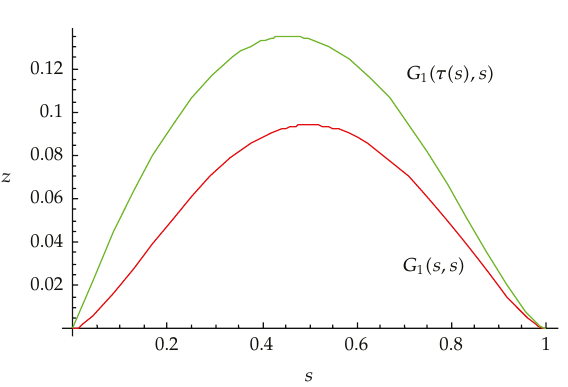
Figure 1: Graph of functions G 1 (cid:6) τ (cid:6) s (cid:7) ,s (cid:7) G 1 (cid:6) s,s (cid:7) for α (cid:8) 5 /